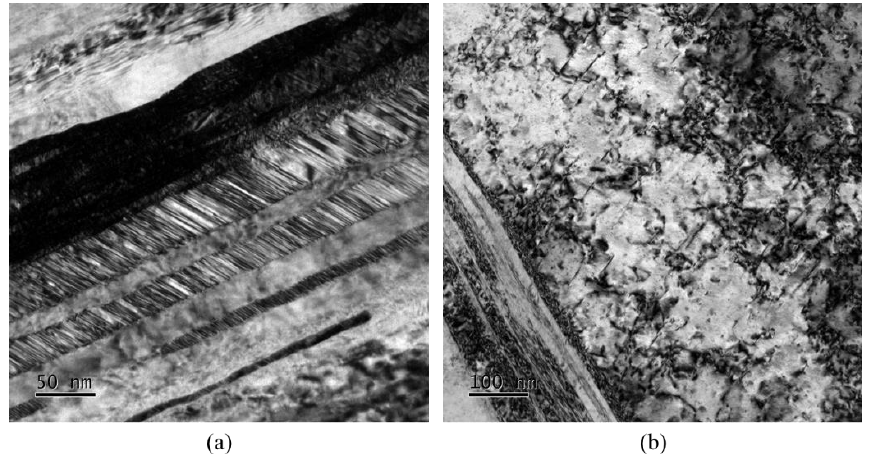
Figure 23. TEM bright-field images of LRPs after impact: ( a ) showing multiple deformation twins in the LRP of FeNiCoCr HEA annealed at 1000 °C, v = 1039 m/s; ( b ) showing high density of stack faults in the initial FeNiCoCr HEA LRP, v = 1429 m/s.